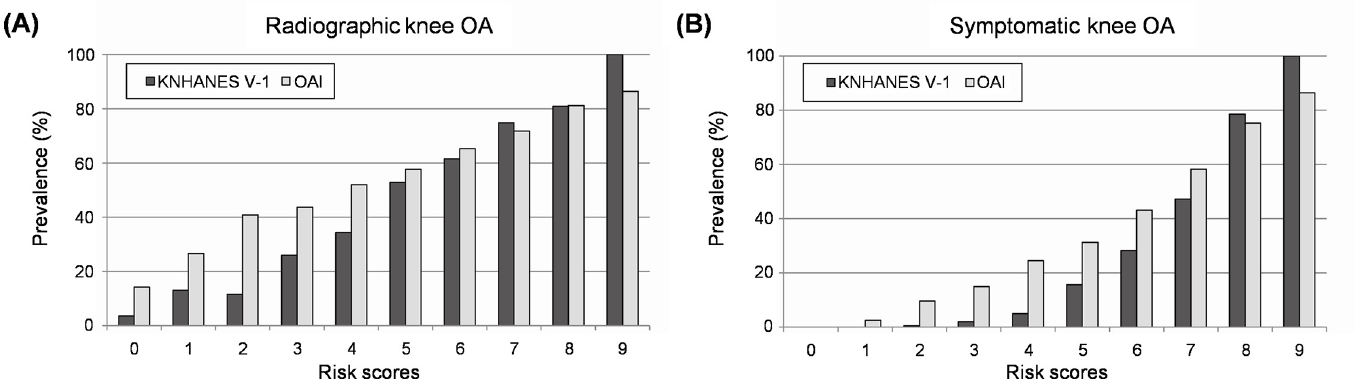
Fig 2. Prevalence of radiographic and symptomatic knee osteoarthritis depending on the risk scores. (A) Prevalence of radiographic knee osteoarthritis. (B) Prevalence of symptomatic knee osteoarthritis. KNHANES, Korea National Health and Nutrition Examination Survey; OA, osteoarthritis; OAI, Osteoarthritis Initiative.